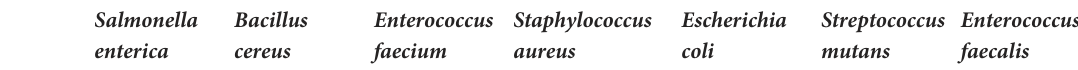
Inhibition zone,